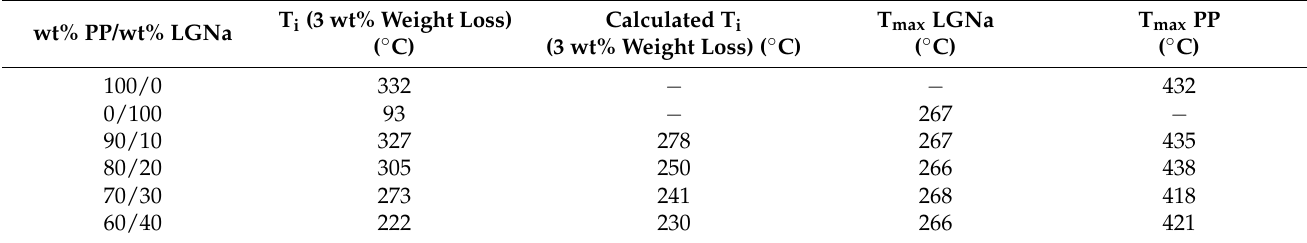
Table 1. Temperature parameters evaluated for PP, LGNa, and its blends.